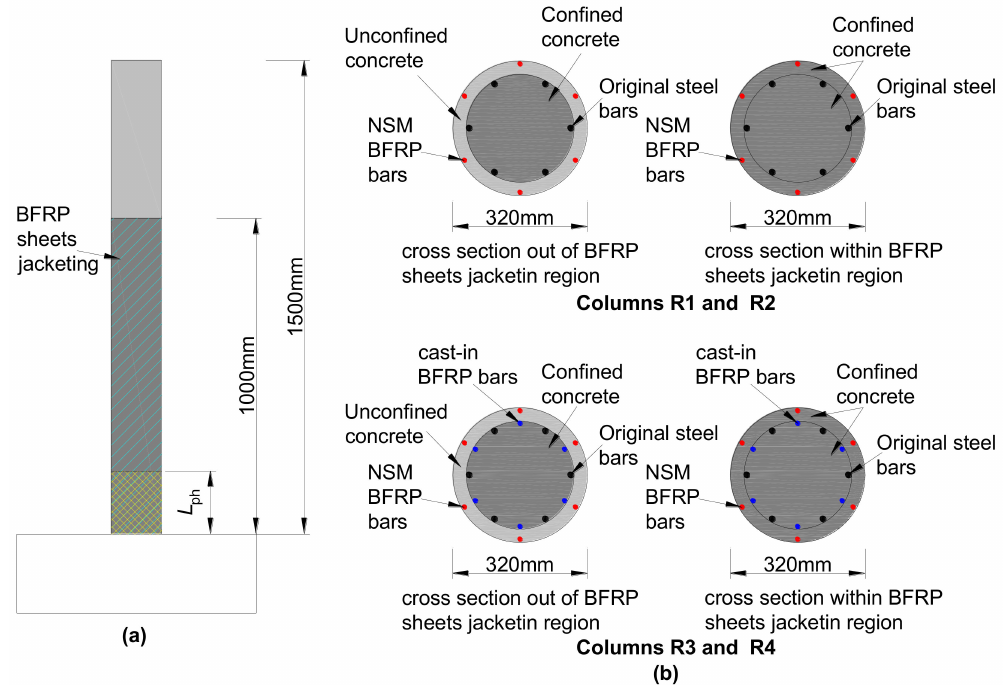
Figure 12. Model of repaired column: ( a ) column element dimensions and ( b ) fiber modeling at section